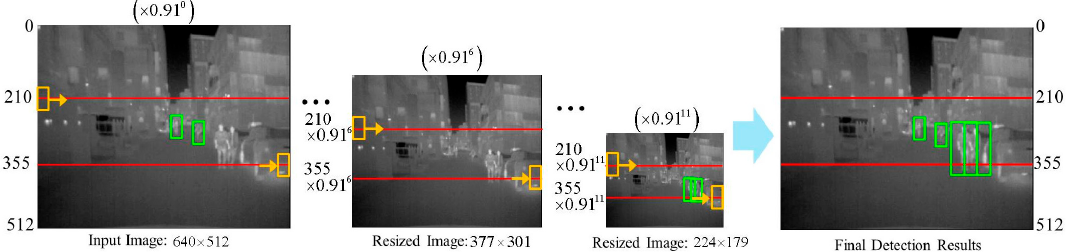
Figure 15. Example of detecting pedestrians of multiple scales using sliding window approach.